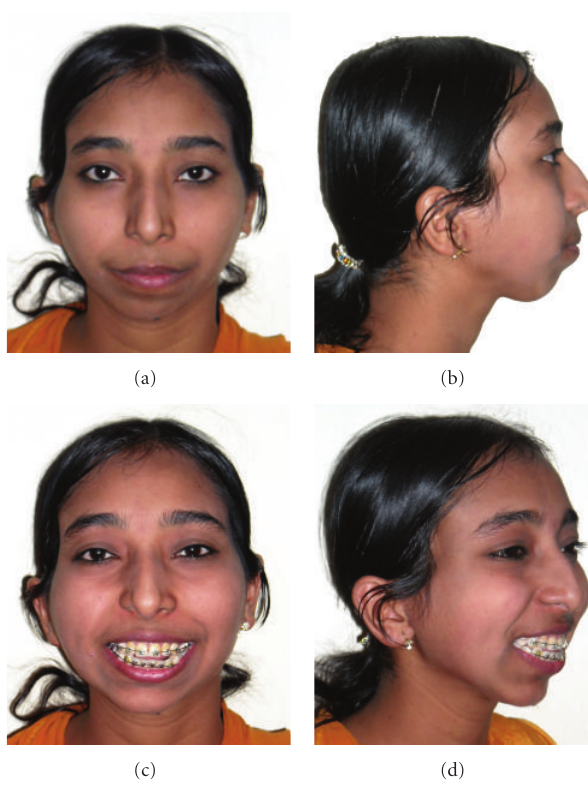
Figure 4: (a)–(d) facial photographs at commencing of orthodontic treatment for bimaxillary protrusion and before